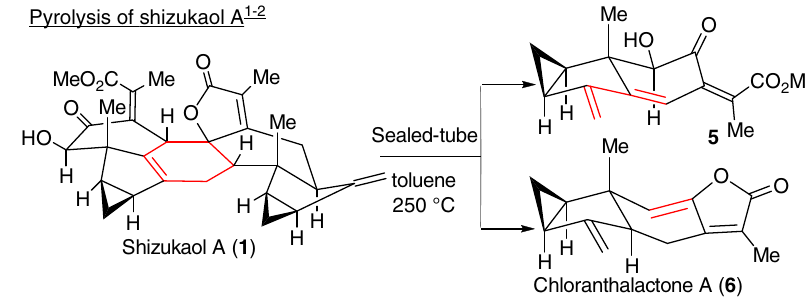
Fig. 2 Pyrolysis of shizukaol A. Shizukaol A was pyrolysized to afford relatively unstable diene 5 and known chloranthalactone A ( 6 ) via a retro Diels – Alder fragmentation of the linking six-membered ring in a sealed tube